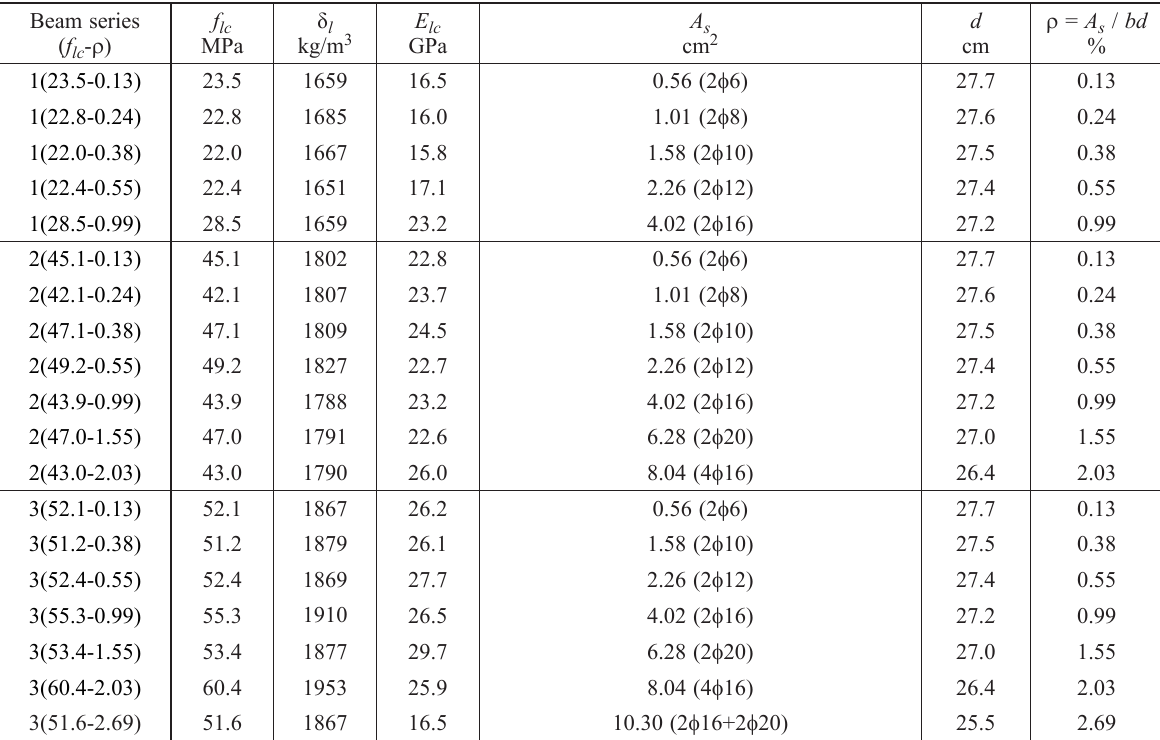
Table 1. Properties of test beams (Bernardo et al. 2014) Beam series ( f lc - r )